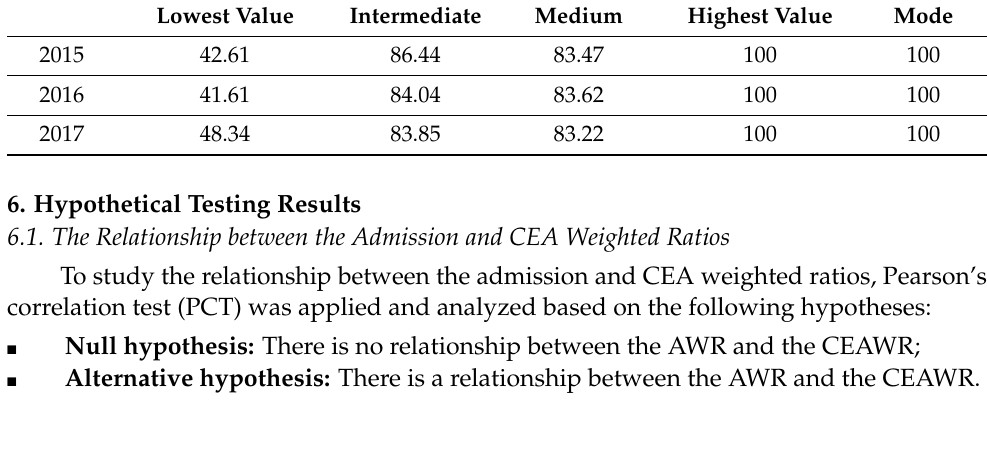
Figure 3. The distribution of students admitted to college after the preparatory year.